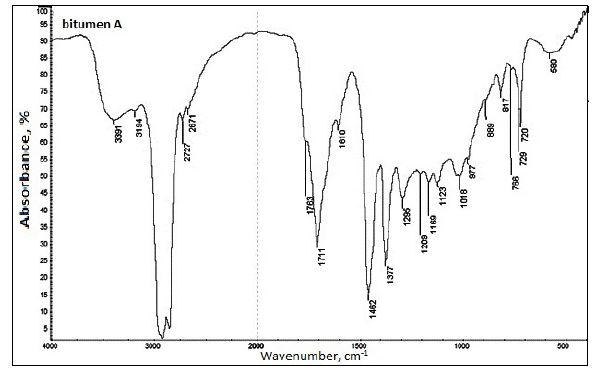
Fig. 3. IR spectrum of bituminous A extracted from Uvur- jargalant’s oil shale